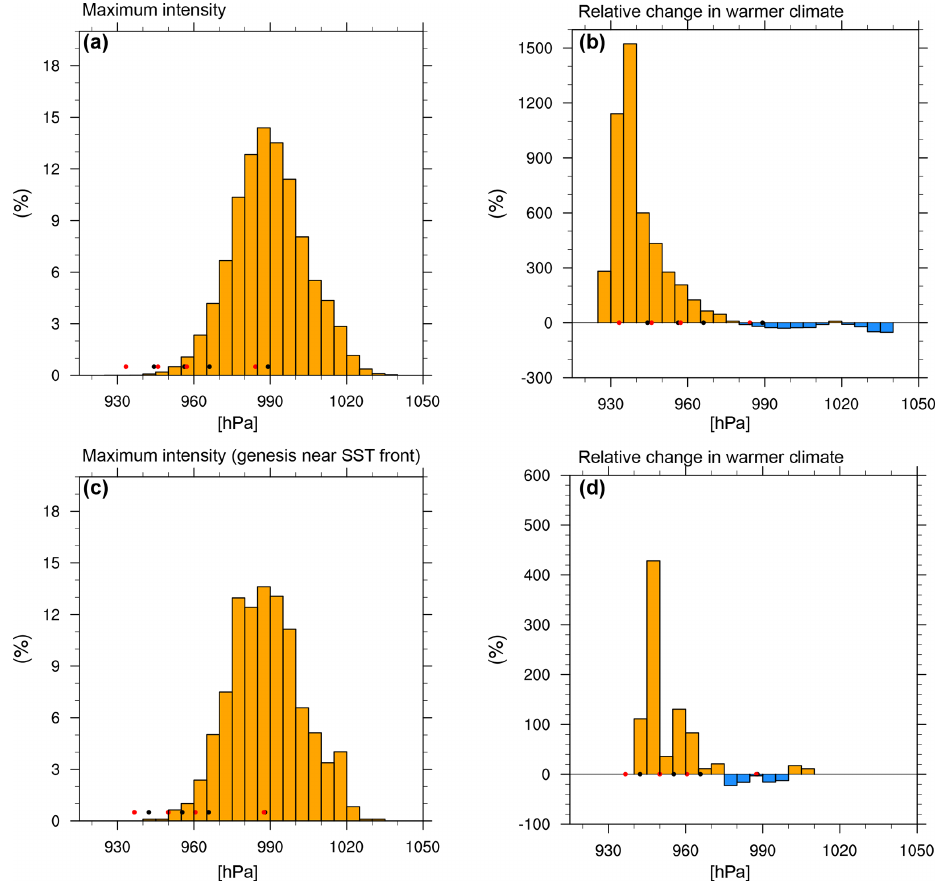
Figure 10. Frequency distribution of maximum intensity, defined as minimum SLP during the entire life cycle, for (a) all cyclones and (c) cyclones with genesis in the vicinity of the SST front in the control simulation. On the lower axes, dots indicate the median and the 95th, the 99th, and the 99.9th percentiles for the control (black) and + 4K (red) simulations. (b, d) Relative change of the distributions shown in (a) and (c) in the + 4K